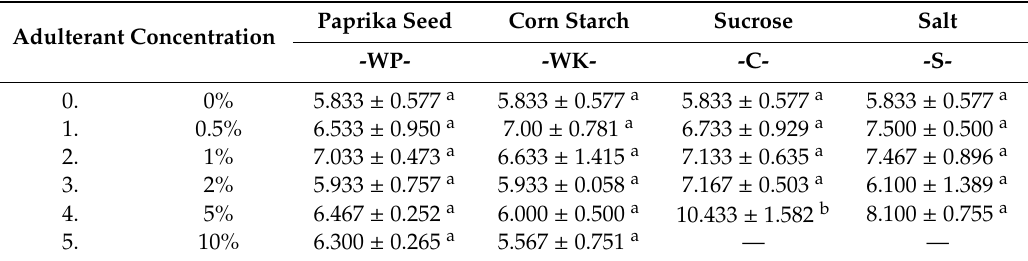
Table 3. Average consistency of tomato pastes by adulterants and concentration levels—in cm / 30 s. Paprika Seed Adulterant Concentration